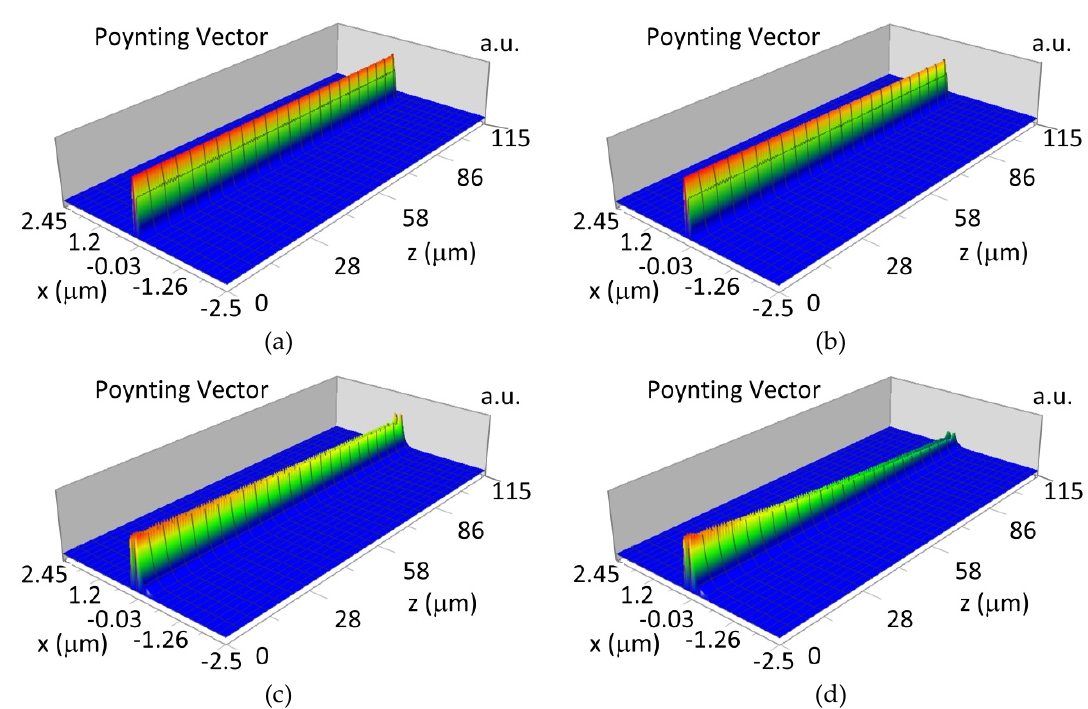
Figure 14. Propagation light in multi-mode waveguide structure for d w = 188 nm, λ = 560 nm (Poynting vector): ( a ) TE00, HbO 2 , ( b ) TE00, Hb, ( c ) TE01, HbO 2 , ( d ) TE01, Hb.